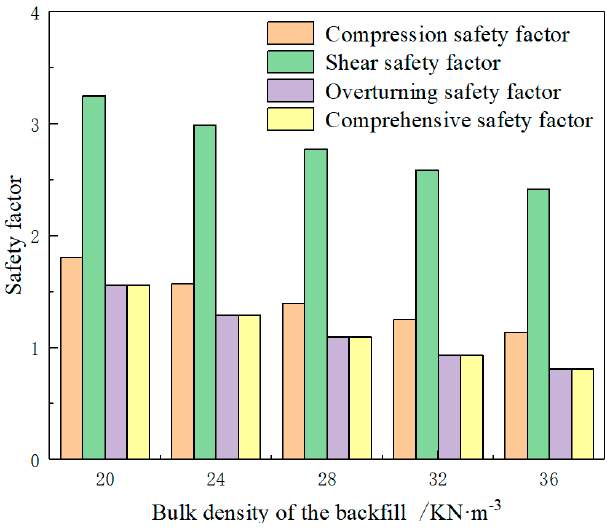
Figure 4. Relationship between safety factor and bulk density of the backfill.